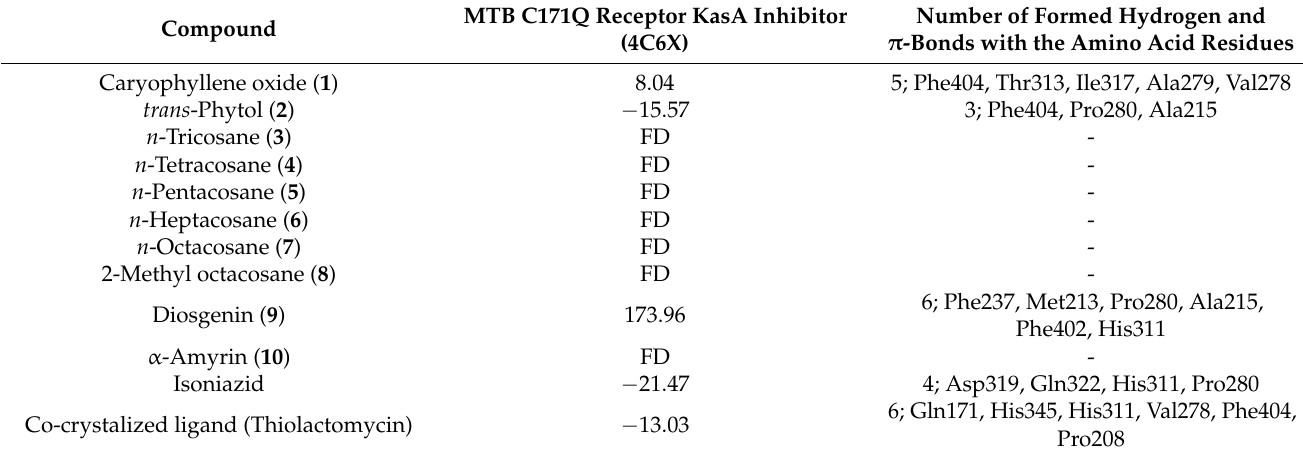
protein with a high fitting score ( ∆ G = − 15.57 kcal/mole) approaching that of isoniazid ( ∆ G = − 21.47 kcal/mole) and exceeding that of thiolactomycin, the co-crystallized ligand ( ∆ G = − 13.03 kcal/mole). This firm fitting is due to the size of the molecule in addition to the formation of three π -alkyl bonds with Phe404, Pro280, Ala215 and Van der Waals interaction with many amino acid residues existing at the active site (Figure 8). Table 3. Free binding energies (kcal/mole) of the identified compounds in the active site of MTB C171Q receptor KasA inhibitor using in silico studies.